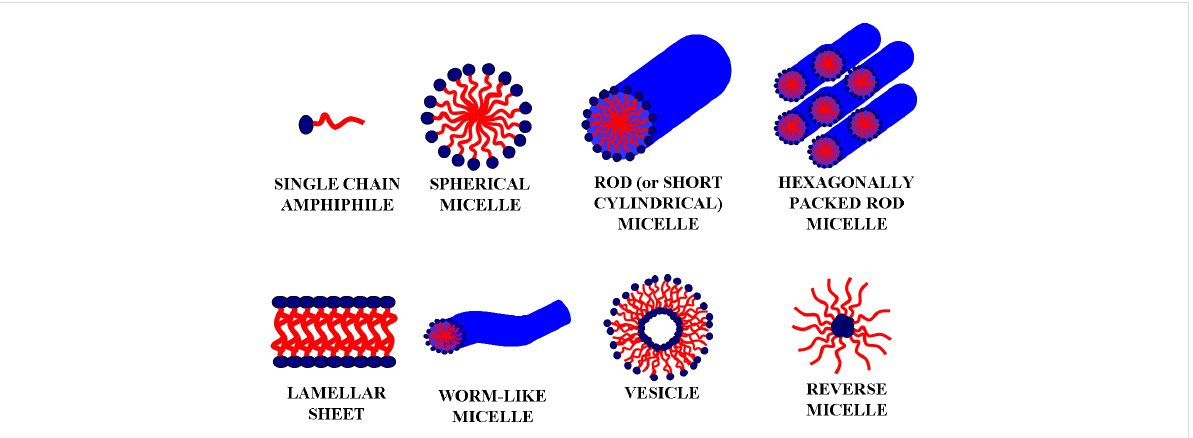
Figure 1: Schematic representation of different micellar architectures. Hydrophilic polar heads are indicated in blue, whereas hydrophobic non-polar tails are drawn in red.